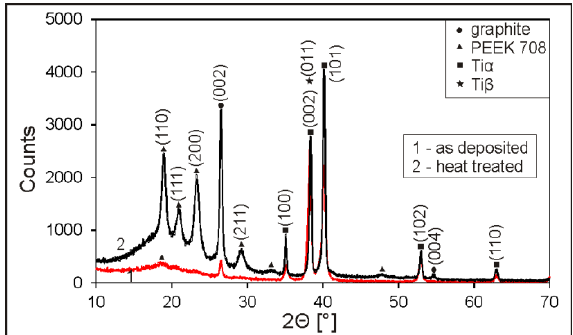
Figure 7. XRD patterns of the graphite / PEEK 708 as-deposited (1) and heat-treated (2) coatings on the Ti-6Al-4V alloy.